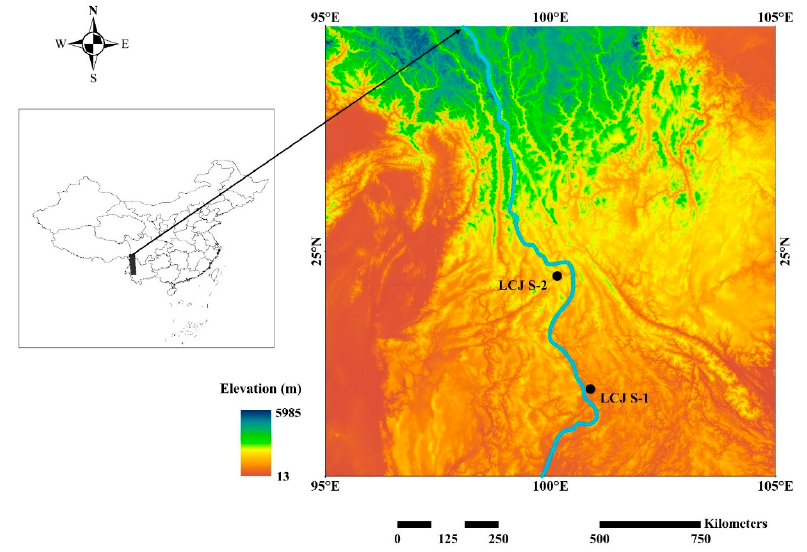
Figure 1. Map of elevation in the Lancangjiang River Basin, Southwest China. (Data of elevation from Geospatial Data Cloud).